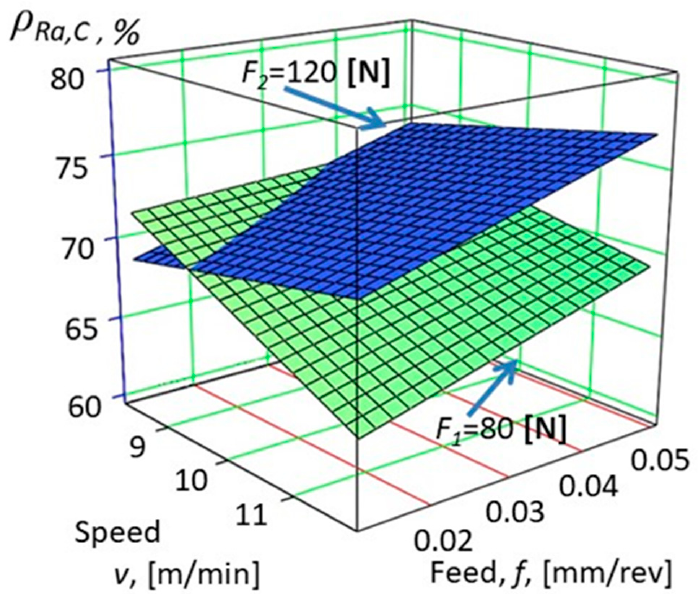
Figure 7. Improvement of the change of surface roughness ρ Ra , C on specimens marked C (see Equation (5)).